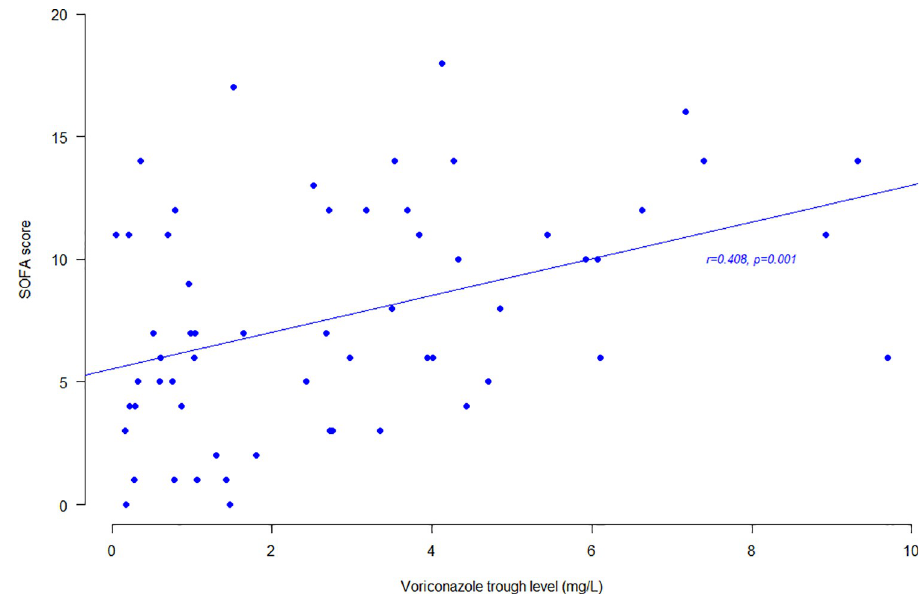
Fig 2. Correlation between SOFA score and voriconazole trough levels. The dots represent the individual pairs for the X–Y variables. The straight line is the linear regression line.